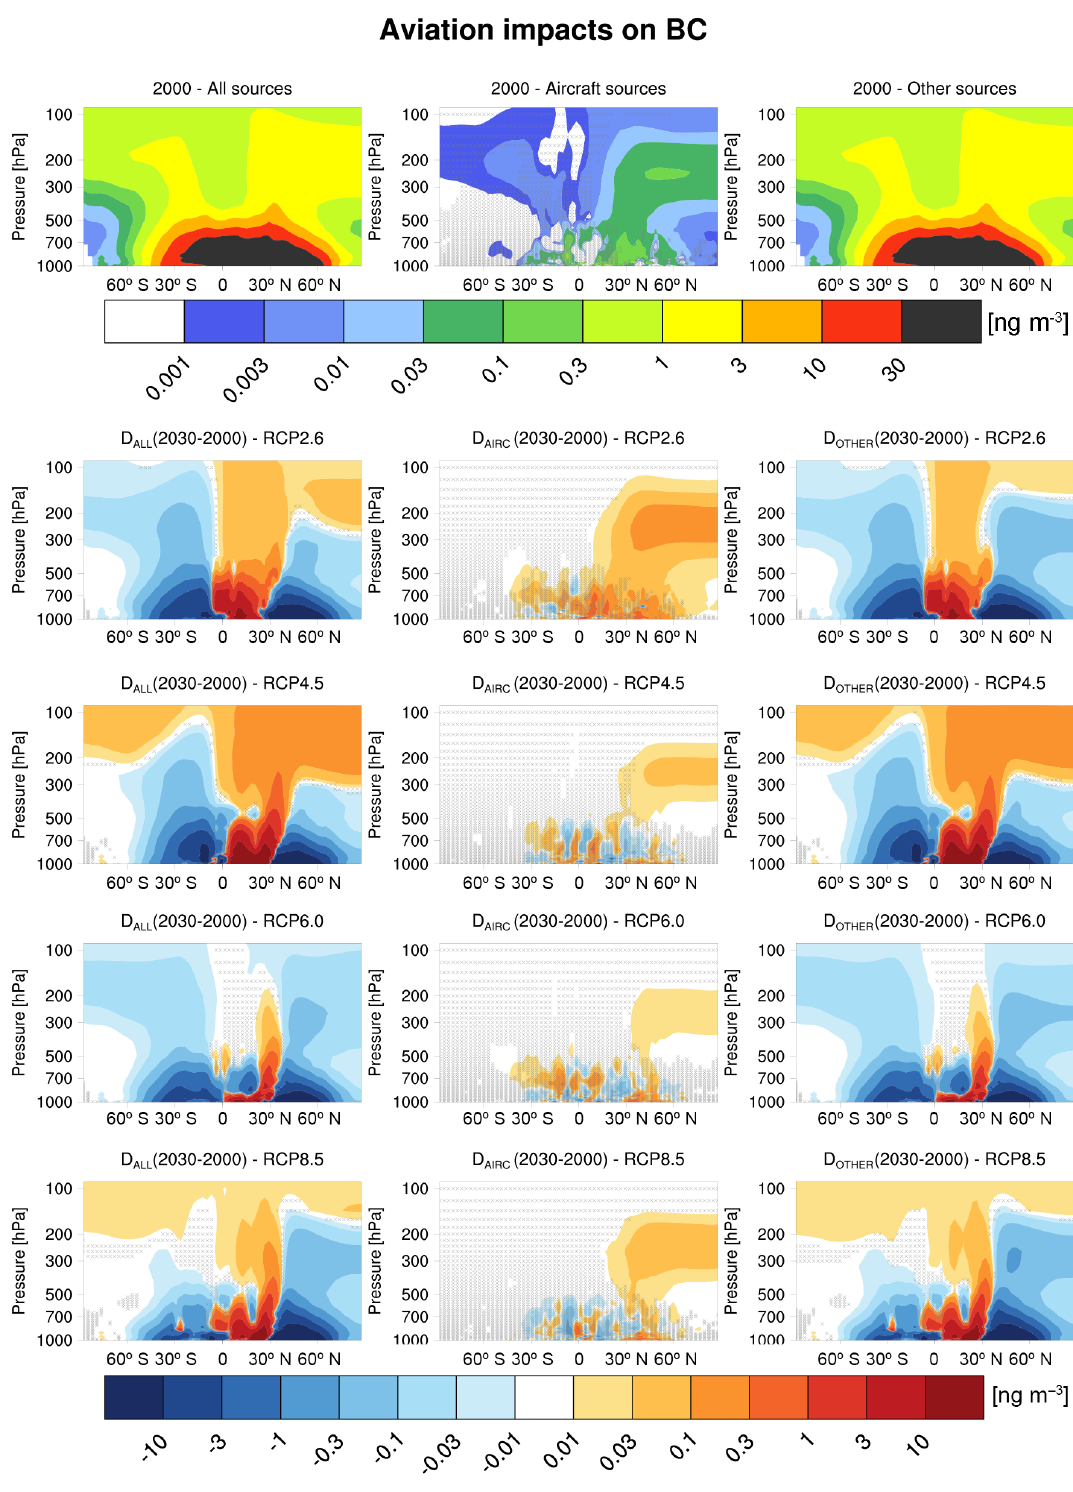
Figure 3. Annual average zonal mean concentrations of BC. The first row shows the results for year 2000 emissions: total concentration (REF 2000 , left), the concentration induced by aviation ( (cid:49) AIRC , middle) and the concentration induced by other sources (NOAIRC 2000 , 2000 right). The lower four rows show the changes in these quantities between 2000 and 2030 for the four RCPs, as given in Eqs. (2)–(4). Grid points are hatched where the difference is not statistically significant according to a univariate t test (5% error